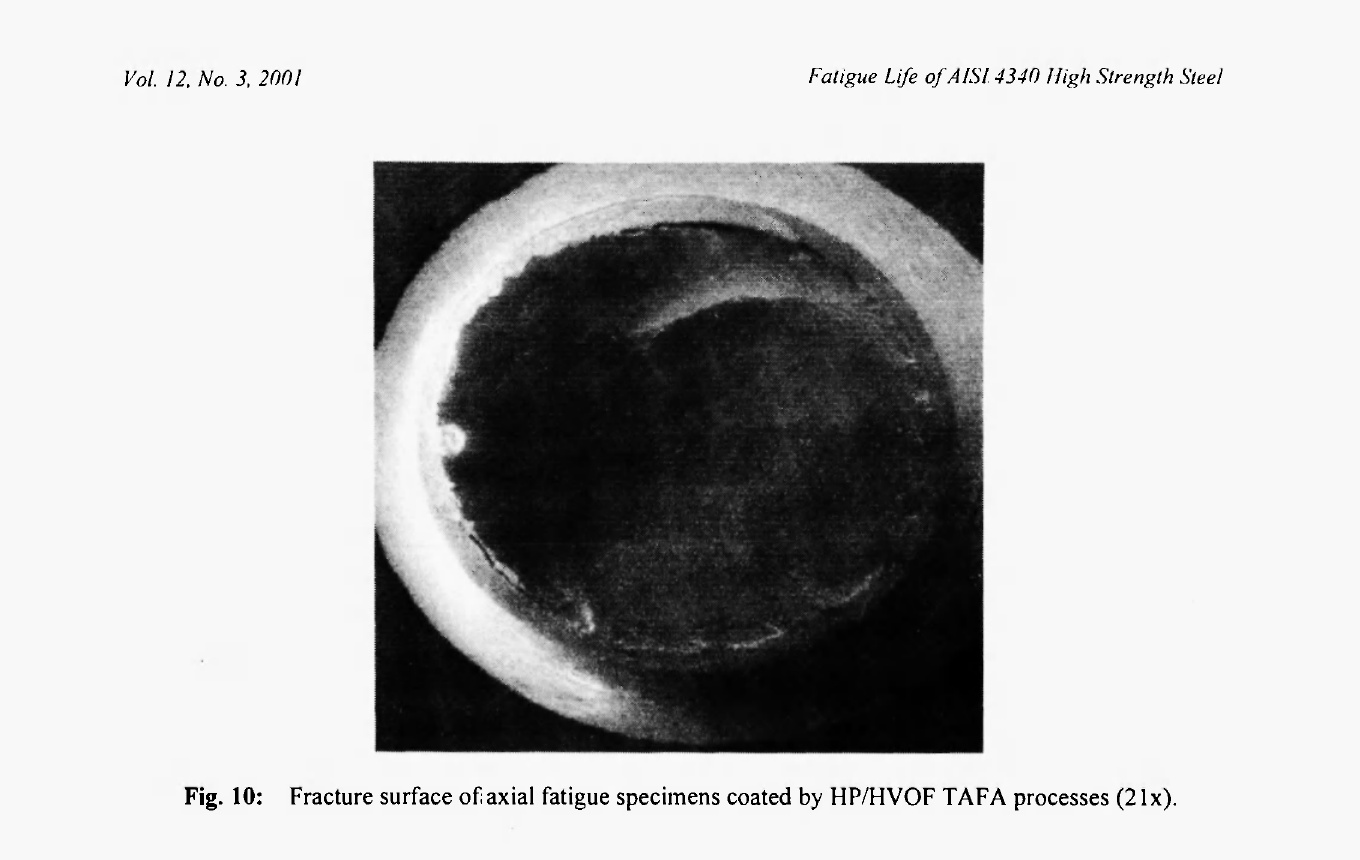
Fig. 10: Fracture surface of axial fatigue specimens coated by HP/HVOF TAFA processes (2 1 x).